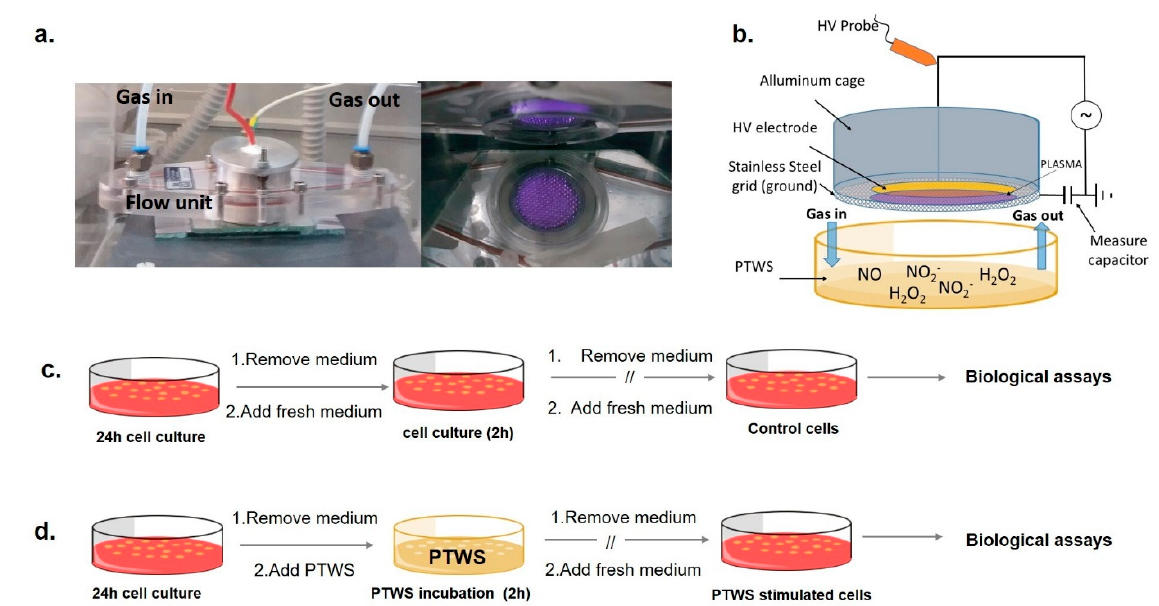
Figure 1. Experimental apparatus and scheme of the biological testing ( a ): left, Plexiglas chamber containing the modified Petri Plas+ plasma source; right, bottom-view of the plasma in air gas feed. ( b ) scheme of the source facing a Petri dish containing the liquid to be treated. After 24 h of cell growth, cells were incubated with 2 mL of ( c ) untreated medium (in case of control samples) and ( d ) Plasma Treated-DMEM (PT-DMEM , in case of PTWS stimulated cells) for 2 h at 37 °C, 5% CO 2 . After, the liquid was replaced with a cell culture medium, and cell cultures were prolonged until biological assays.